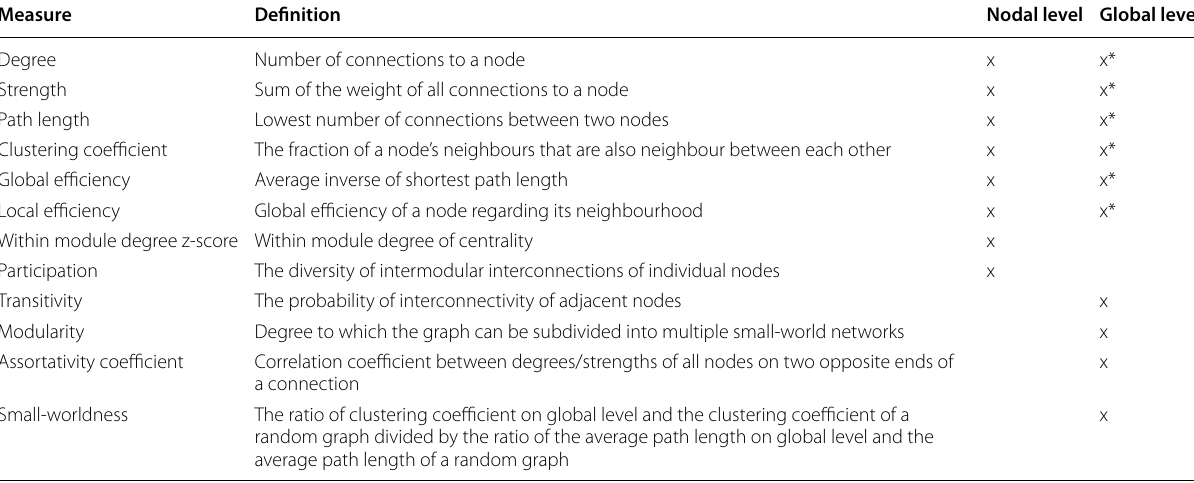
*Network parameters at global level were calculated by averaging the outcome of nodal measures over all ROI’s